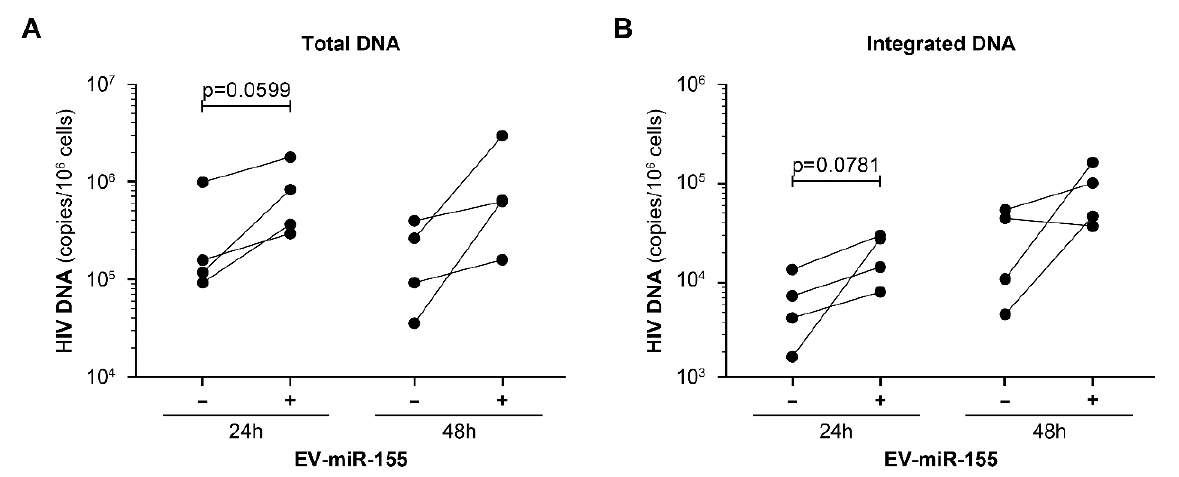
Figure 6. Vesicular miR-155 increases short-term HIV DNA production and integration. PBMCs from different donors were contacted with NL4.3BE or NL4.3BE/EV-miR-155 and cultured for 24 h and 48 h. Total ( A ) and integrated ( B ) HIV DNA was measured by a nested PCR assay. Each dot represents one donor. The significant difference for total and integrated HIV DNA measurement between PBMCs treated or non-treated at either 24 h or 48 h with miR-155-enriched EVs is based on a parametric paired t-test.